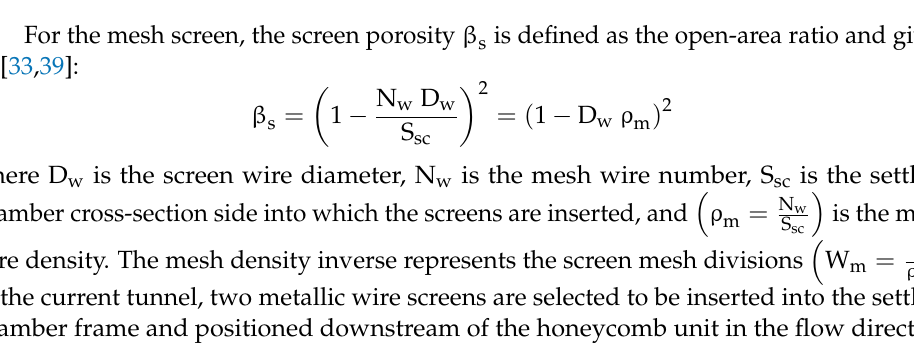
Figure 5. The 3-D model of the honeycomb with square cells.